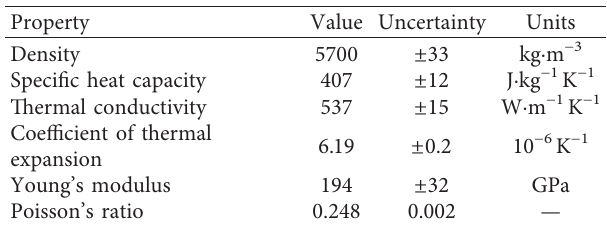
Figure 16: Structural model “simply-supported” boundary con- dition setup (bold edges constrained in X -direction). Table 4: Summary of the material model for CuCD RHP3434 at room